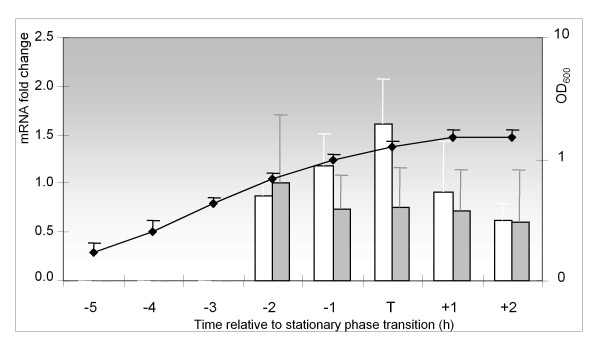
Temporal transcription of sigH. Growth of RV2002 has been monitored by OD600 (right axis). Time is indicated in hours relative to the approximate transition to stationary phase (T). mRNAs levels of ldh (grey blocks) or sigH (white blocks) were measured by qPCR and expressed as fold change relative to an early-exponential calibrator sample (left axis). For sigH, results have been further normalized by ldh mRNA levels and expressed as sigH/ldh ratio. Error bars represent standard deviation. A fold change of 1 indicates a constant level of transcripts.